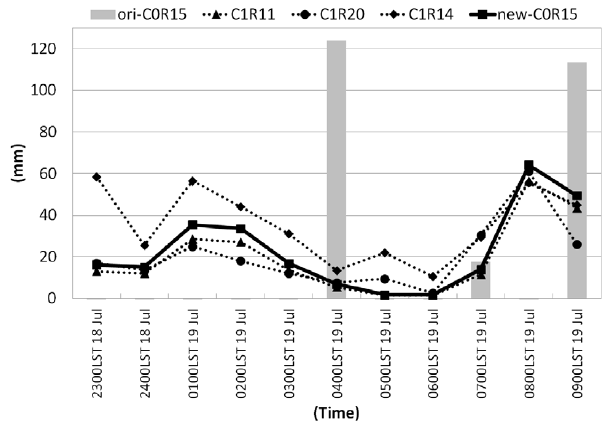
Fig 2. Rainfall data collected by the Sandimen (C0R15), Guxia (C1R11), Long-Cyuan 2 Fig. 2. Rainfall data collected by the Sandimen (C0R15), Guxia (C1R20), and Majia (C1R14) stations between 2300 LST 18 July and 0900 LST 19 3 (C1R11), Long-Cyuan (C1R20), and Majia (C1R14) stations be- tween 23:00 LST, 18 July and 09:00 LST, 19 July. 4